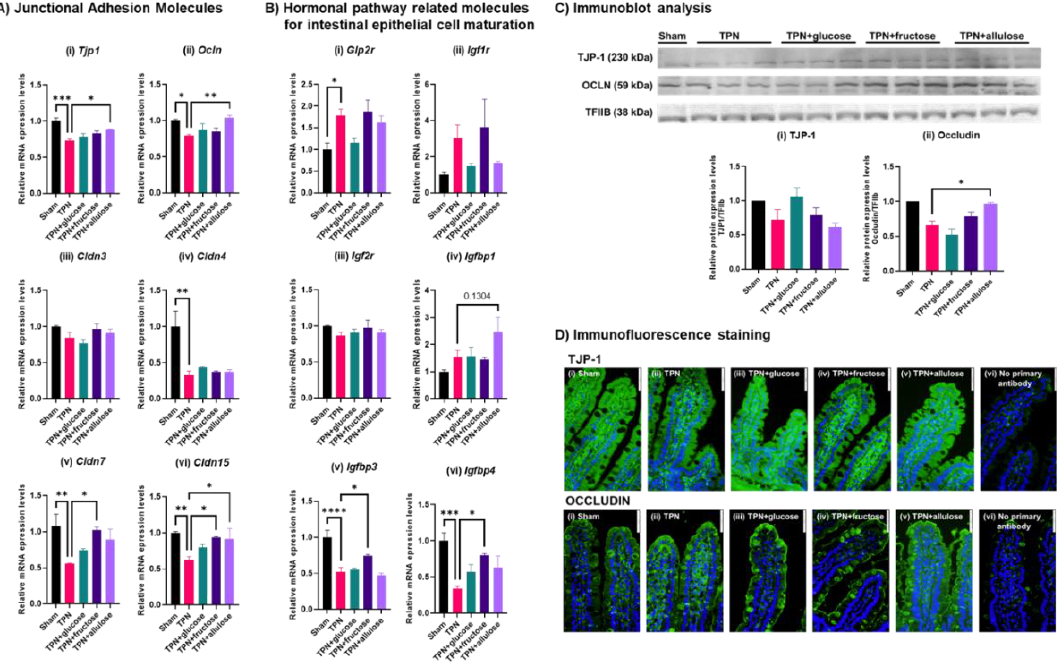
Figure 7. Expression analysis of representative molecules involved in intestinal barrier function and hormonal pathway molecules related to intestinal epithelial cells maturation in TPN model of rats. ( A ) Results of qRT-PCR for junctional adhesion molecules-related genes, ( i ) Tjp1 , ( ii ) Ocln , ( iii ) Cldn3 , ( iv ) Cldn4 , ( v ) Cldn7 and ( vi ) Cldn15 . ( B ) Results of qRT-PCR for hormonal pathway-related molecules for intestinal epithelial cell maturation related genes, ( i ) Glp2r , ( ii ) Igf1r , ( iii ) Igf2r , ( iv ) Igfbp1 , ( v ) Igfbp3 and ( vi ) Igfbp4 . Values indicate mean ± SEM ( n = 4). ( C ) Results of immunoblot analysis for tight junction protein 1 (TJP-1) and occludin (OCLN). Transcriptional factor IIB (TFIIB) is internal control. The graphs indicate relative protein expression levels when the value of Sham group is 1.0. Values indicate mean ± SEM ( n = 3). Asterisks indicate significant differences tested using the ANOVA- Dunnett’s multiple comparisons test (vs. TPN group, **** p < 0.0001, *** p < 0.001, ** p < 0.01, * p < 0.05). ( D ) Results of immunofluorescence staining in jejunal sectional samples, ( i ) Sham, ( ii ) TPN, ( iii ) TPN + glucose, ( iv ) TPN + fructose, ( v ) TPN + allulose and ( vi ) no primary